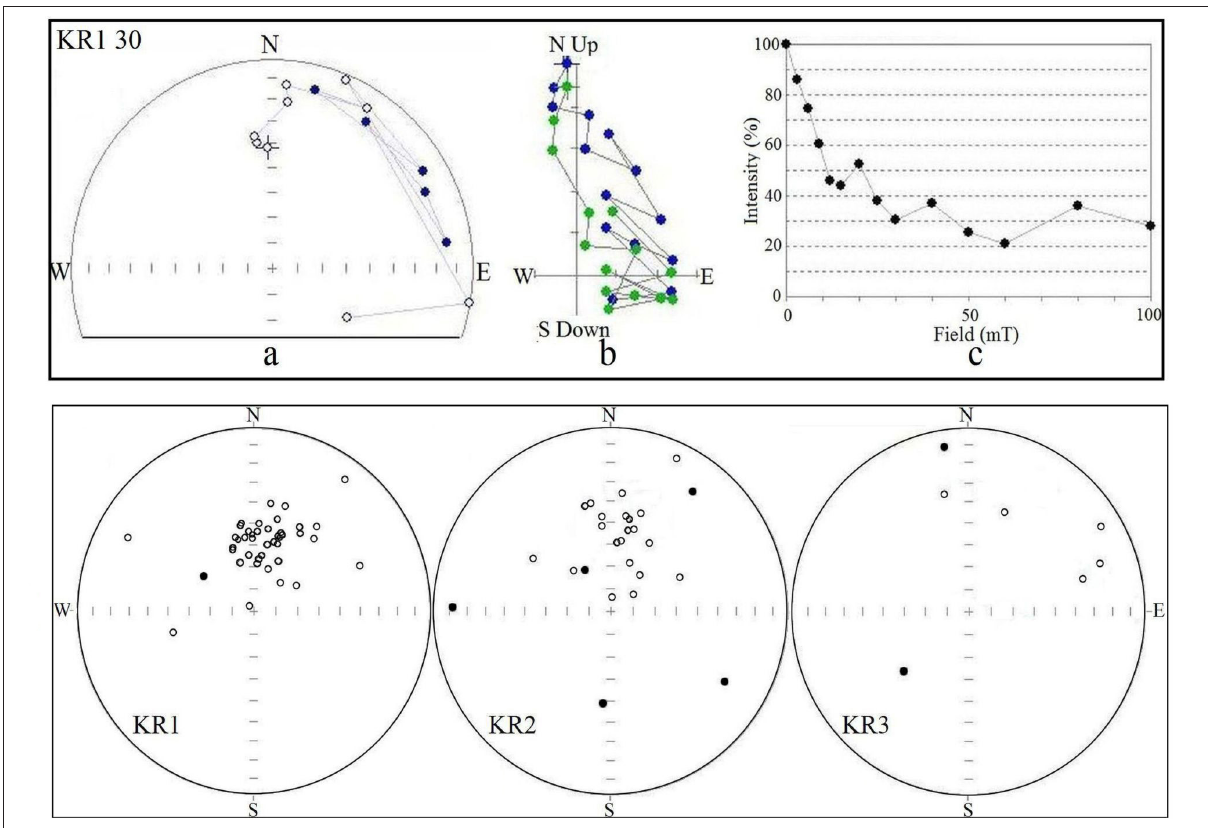
Figure 5: (upper) Example of an unreliable sample to isolate directions from KR1 (#30) showing more than one component, contained in a very low inclination plane: (a) stereographic projection, (b) Zijderveld diagram and (c) demagnetisation curve. (lower) Stereographic projections of directional data with field correction of characteristic remanent magnetisations of each sample for the sections reported in this paper. Negative inclination is indicated by open circles and positive inclination by solid